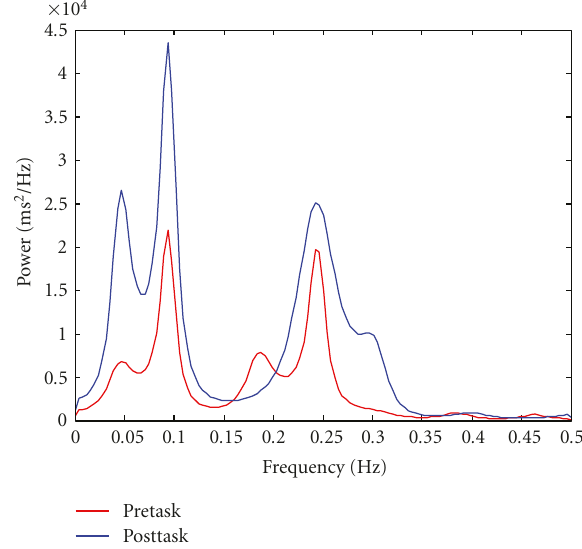
Figure 3: Example of power spectral of HRV in the pretask and